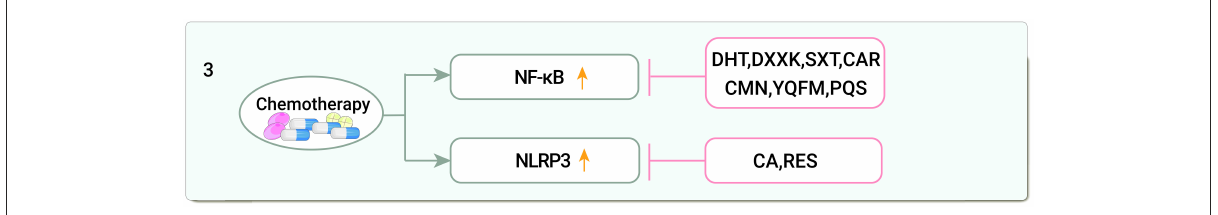
FIGURE3 Traditional Chinese medicine alleviates cardiotoxicity associated with chemoradiotherapy by anti-inflammatory (NF- κ B, Nuclear factor kappa-B; NLRP3, Sirtuin1 (Sirt1)-nod-like receptor protein 3; DHT, Dihydrotanshinone I; DXXK, Di’ao Xinxuekang capsule; SXT, Shengxian decoction; CAR, Cardamom; CMN, Curcumin; YQFM, Yiqi Fumai lyophilized injection; PQS, Panax quinquefolius ; CA, Calycosin; RES,